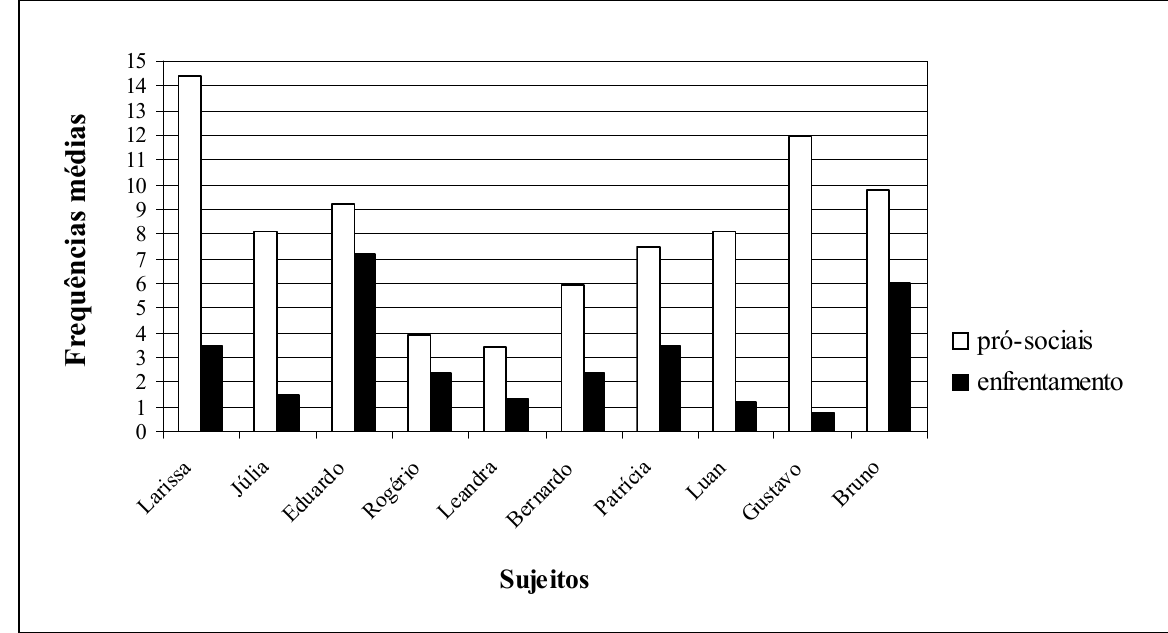
Figura 2 . Frequências médias das habilidades pró-sociais e de enfrentamento exibida pelos sujeitos no que se refere às classes de habilidades investigadas.